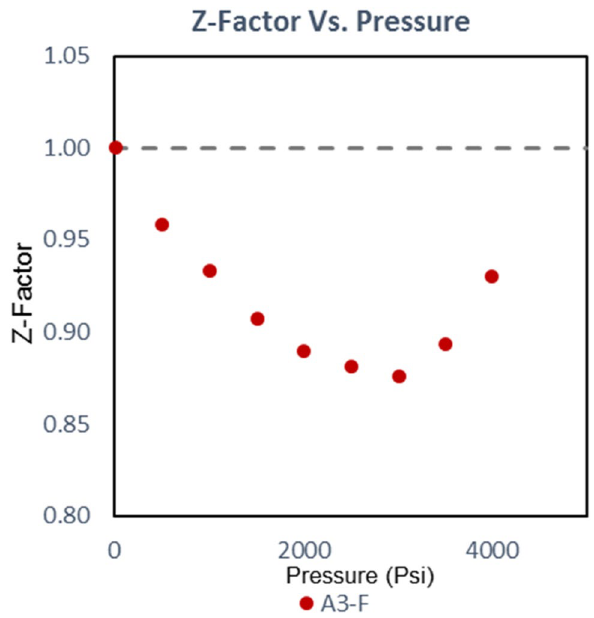
Fig. 12 Valid trend of relative volume—CCE test Fig. 13 Valid trend of gas compressibility factor—DL test